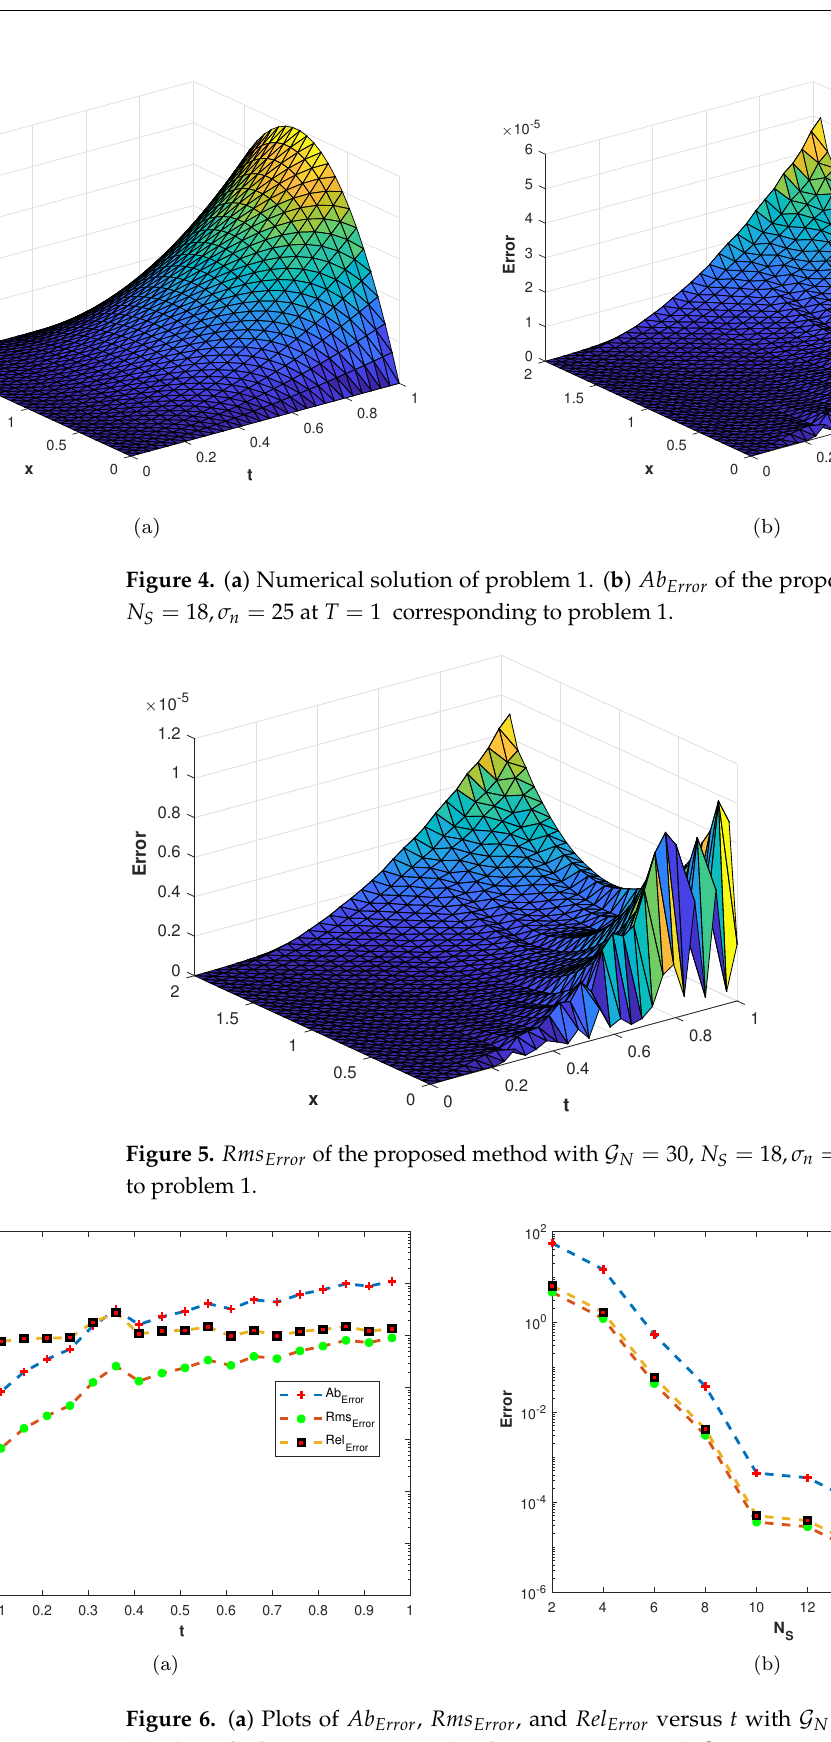
Figure 6. ( a ) Plots of Ab Error , Rms Error , and Rel Error versus t with ( b ) Plots of Ab Error , Rms Error , and Rel Error versus N S with